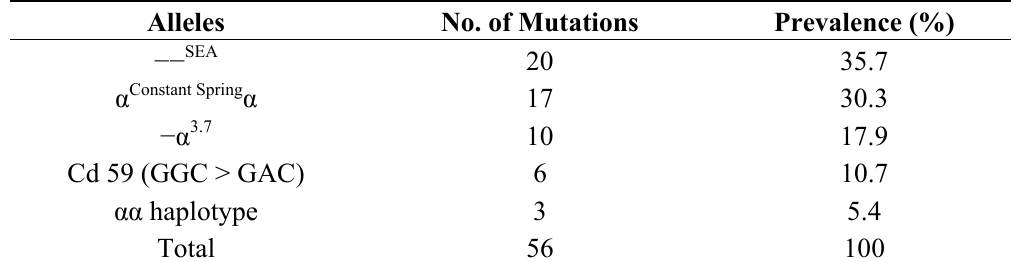
Table 1. Spectrum of α -thalassaemia gene defects identified in Malay patients by multiplex Gap- and ARMS-PCR.